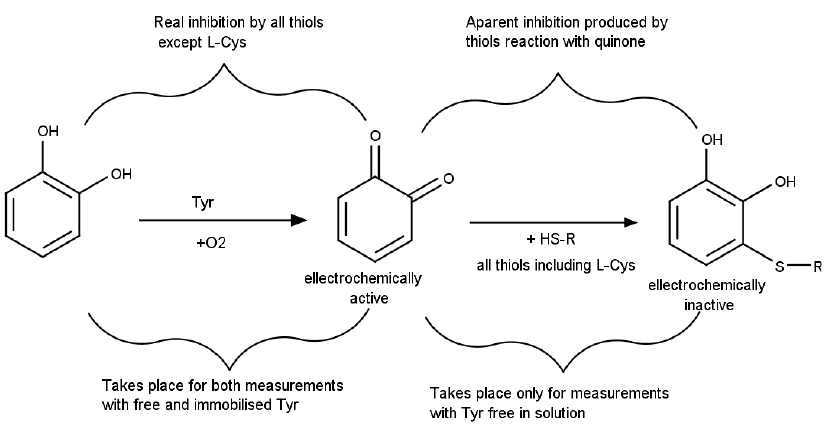
Figure 2. The detection strategy to selectively detect L -Cys without interferences from thiols using tyrosinase (Tyr). Both a classical Tyr inhibition and an analytical signal reduction due to product reaction with thiols are employed.